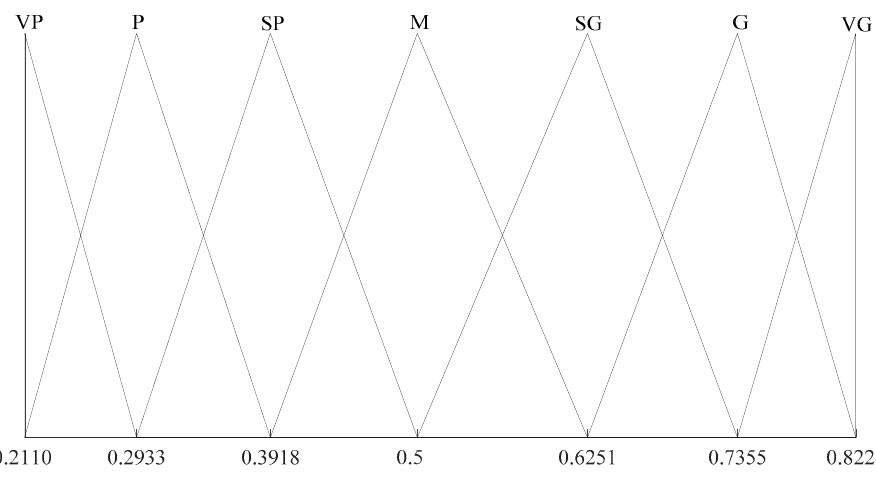
* S  . Figure 1. Distribution of the semantic values of the generalized linguistic term sets (GLTS) (cid:101) S ∗ 1 1